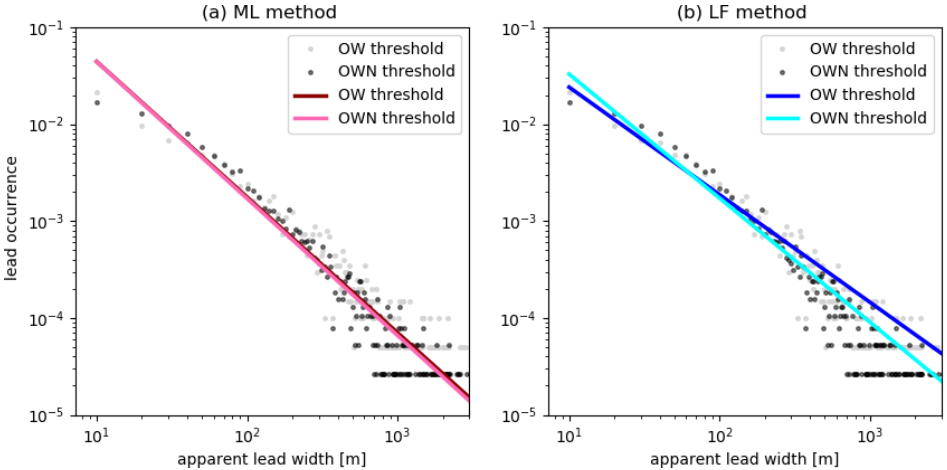
Figure 6. Same as Fig. 5 but with the results for both thresholds for (a) the ML fitting method and (b) the LF fitting method.